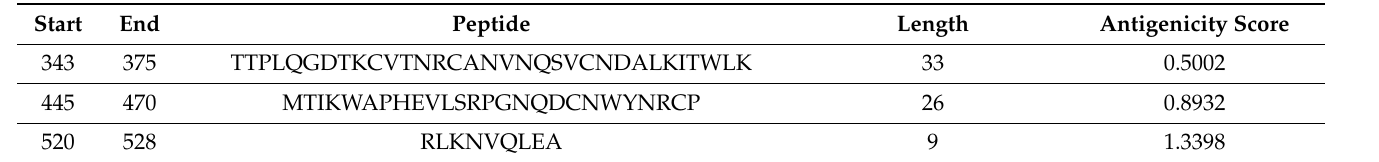
Table 2. Selected B-cell epitopes for the